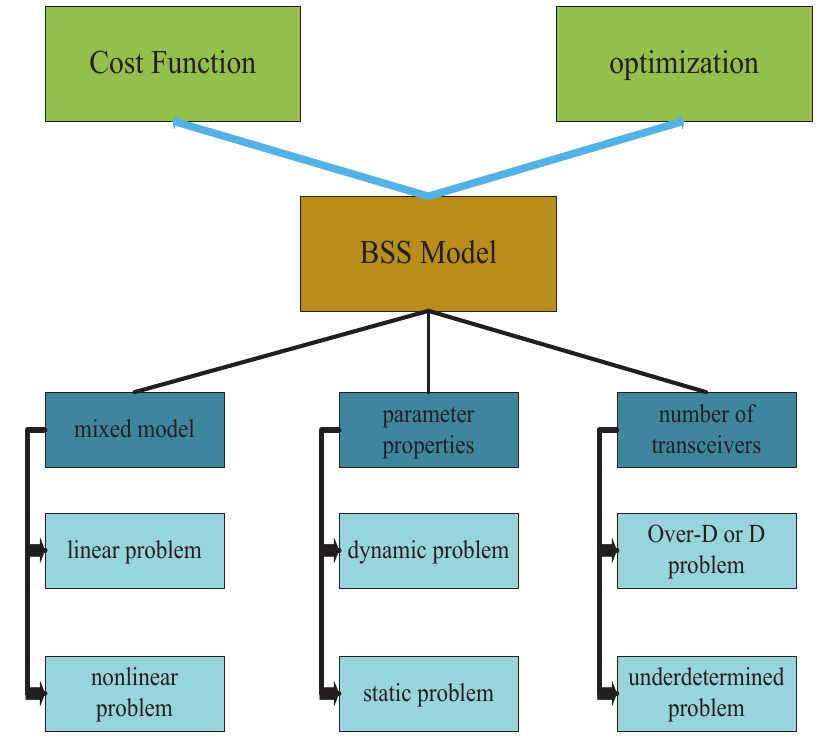
Figure 3. Basic elements of BSS